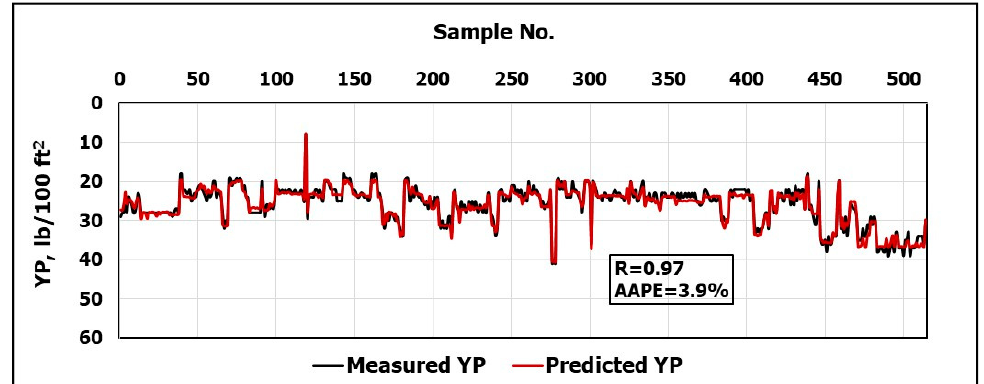
(11) Table 4. The optimized coefficients for estimating the normalized 𝑌 (cid:3017)(cid:3041) in Equation (10). Neuron Index